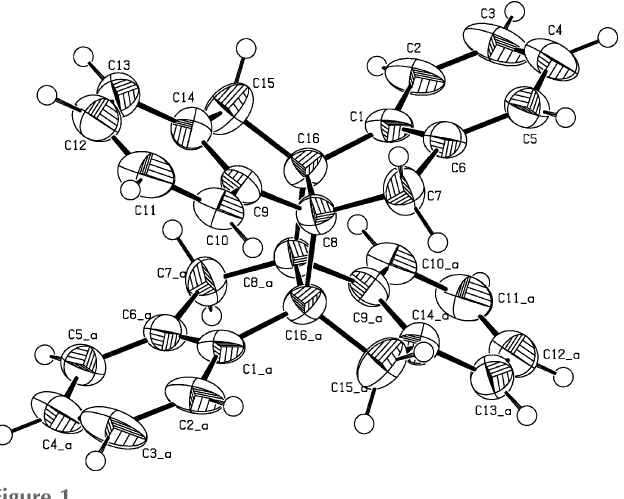
Figure 1 Perspective view of the title compound. Displacement ellipsoids are drawn at the 50% probability level. The second part of the molecule is generated by the symmetry operation 1 (cid:4) x , 1 (cid:4) y , 1 (cid:4) z